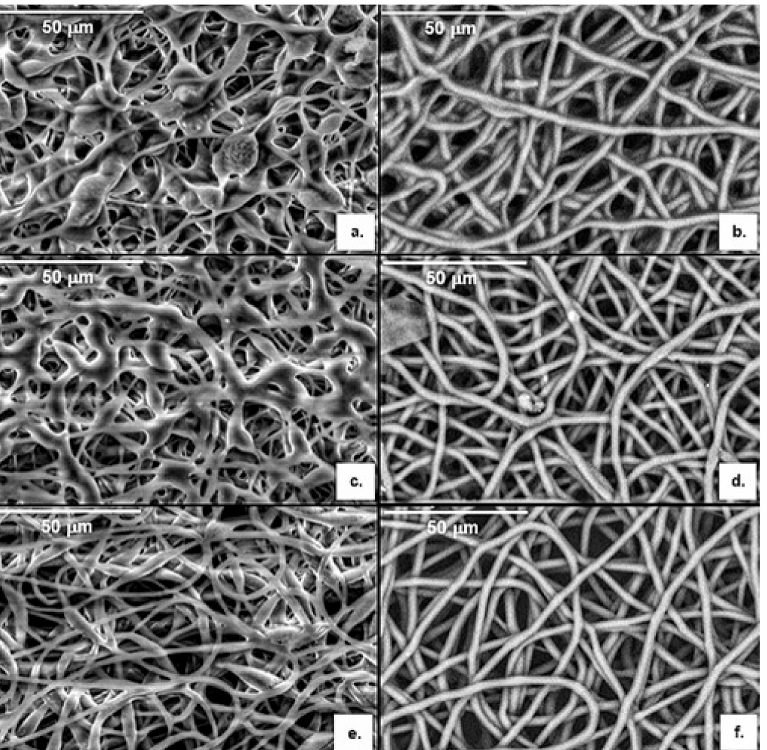
Figure 3. Images obtained by Scanning Electron Microscopy (SEM) analysis of the electrospun P(3HB): mcl-PHA fibers at blend ratios of 50:50 ( a ), 60:40 ( c ) and 70:30 ( e ) and the